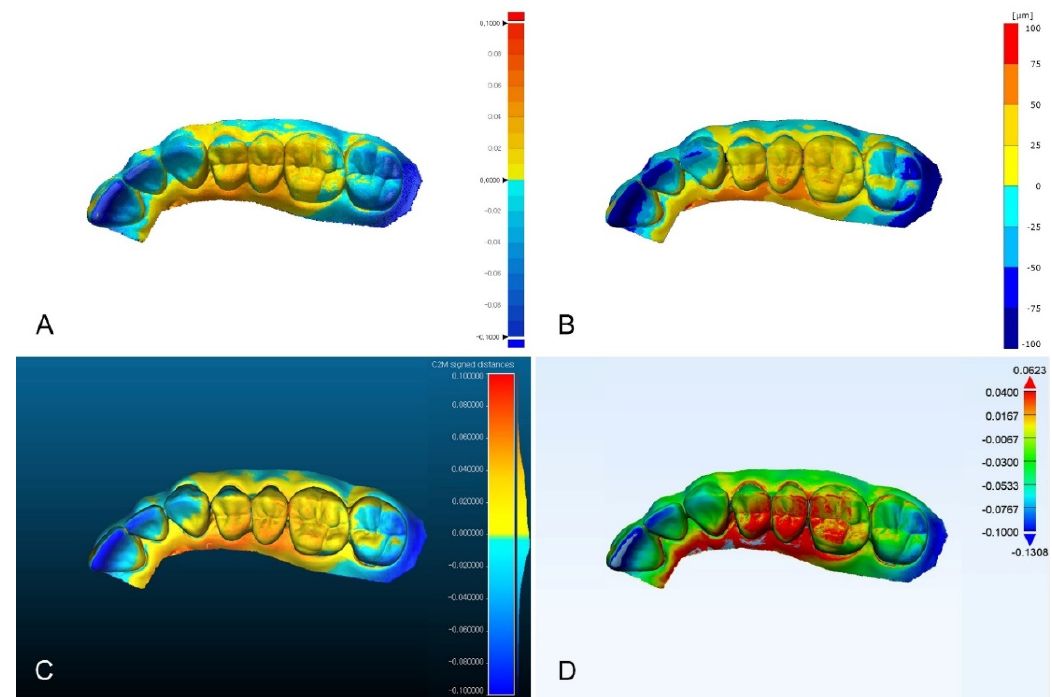
Figure 4. Comparison of color difference maps of half-arch region evaluated by using four analysis software programs. ( A ) Geomagic control X; ( B ) GOM Inspect; ( C ) Cloudcompare; ( D ) Materialise 3-matic.